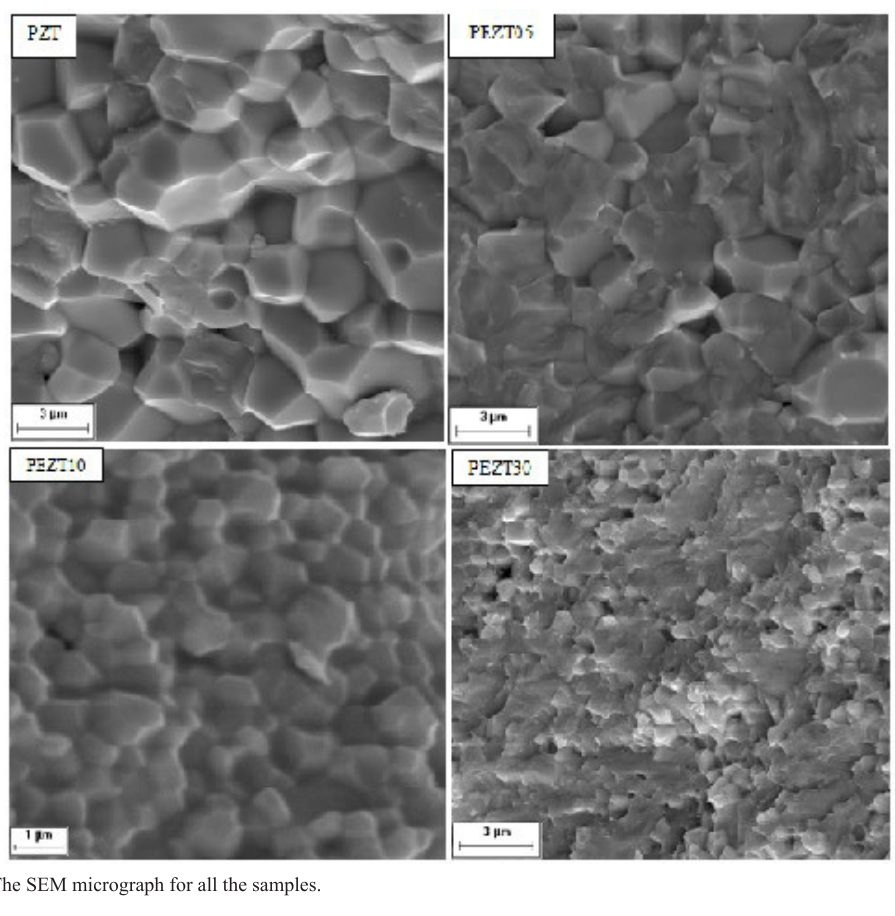
Figure 4. The SEM micrograph for all the samples.